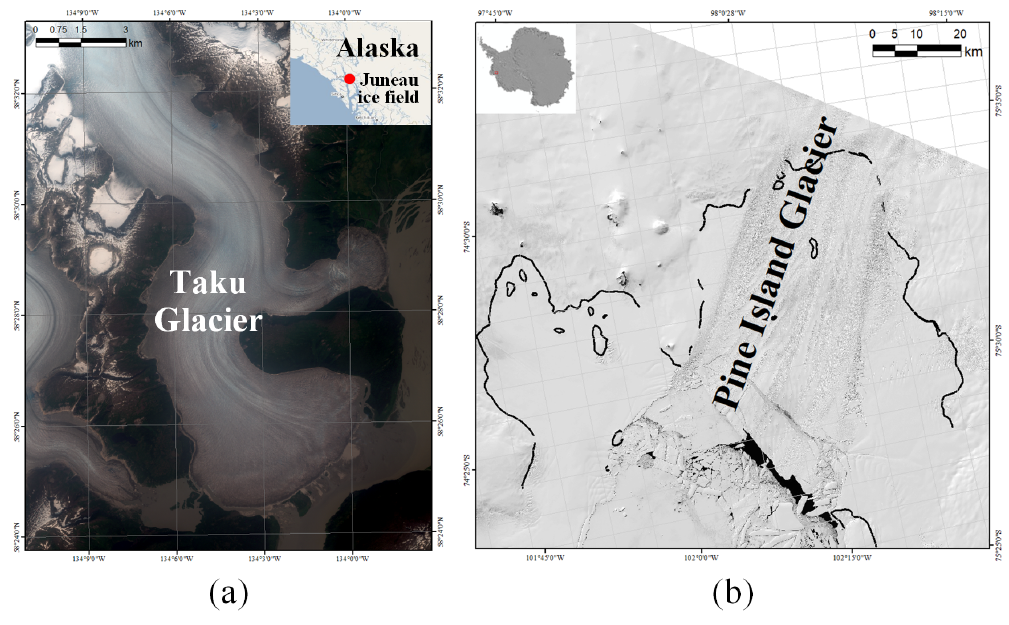
Figure 3. Illustration of the study area. ( a ) Taku Glacier; and ( b ) Pine Island